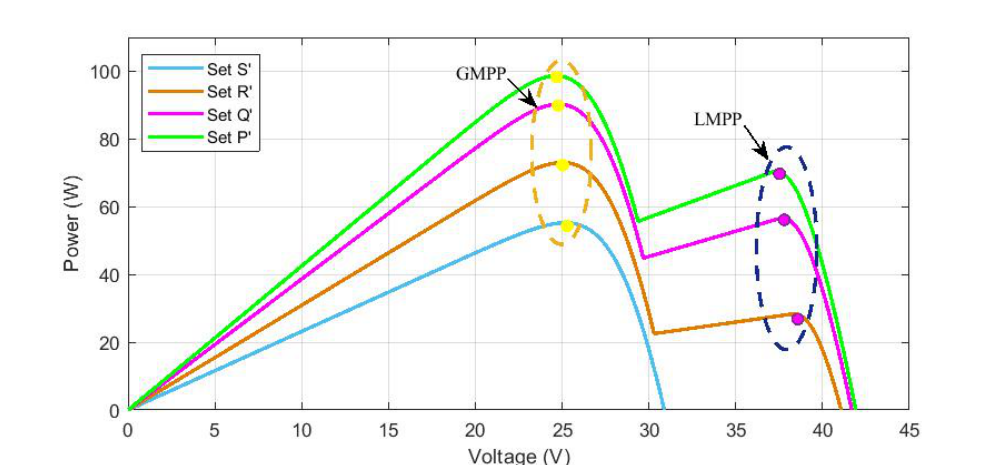
Figure 15. P–V characteristics in different sets of partially shading.